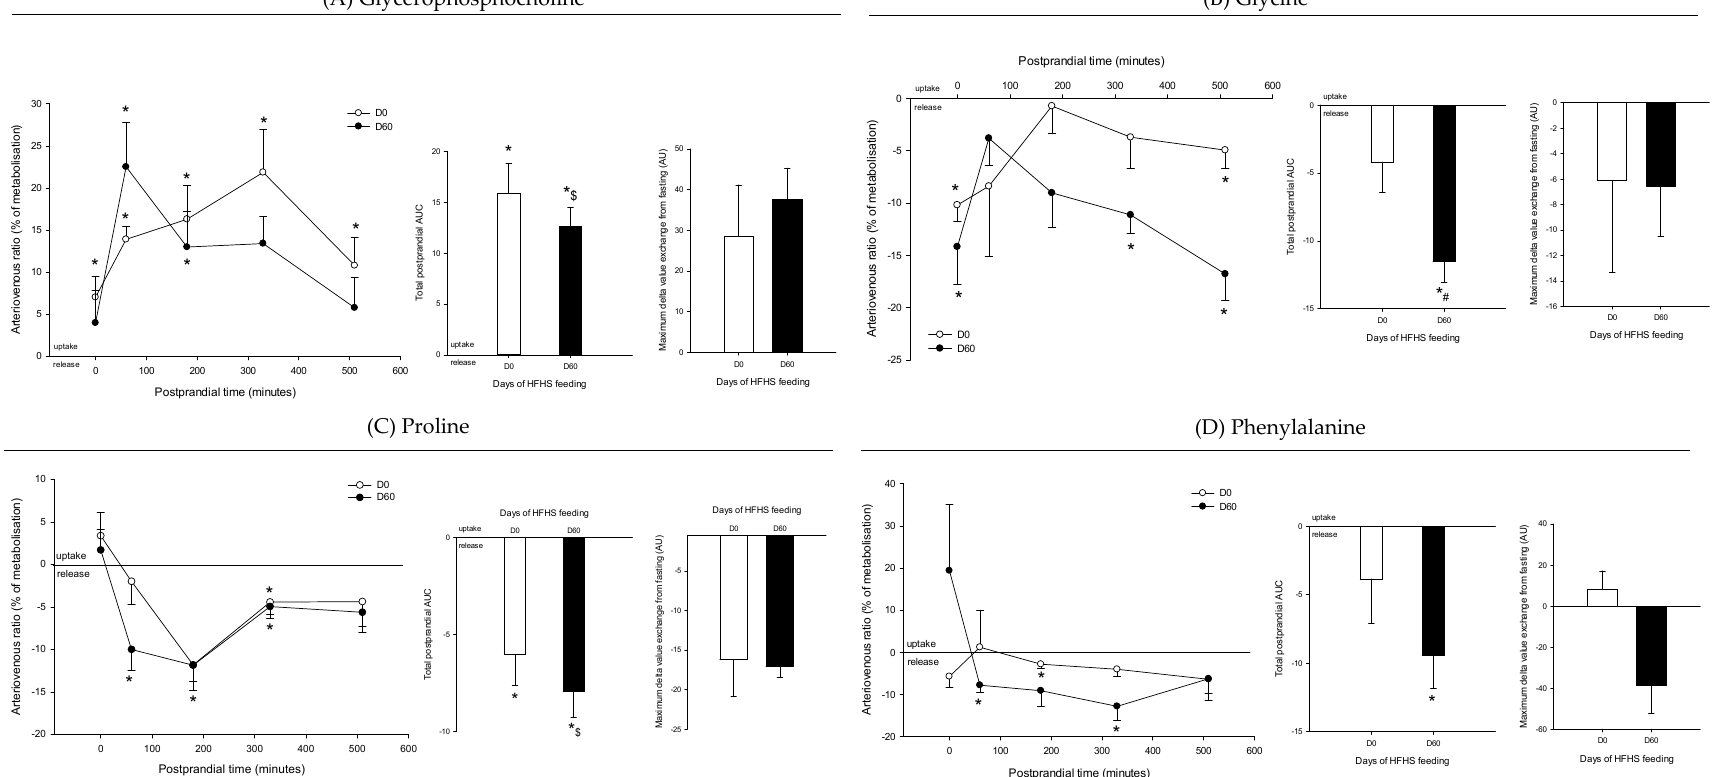
Figure 9. Arteriovenous fold change (A/V) of ( A ) glycerophosphocholine, ( B ) glycine, ( C ) proline, and ( D ) phenylalanine across the intestine on five Yucatan mini-pigs submitted to a HFHS diet during two months. Data is presented in % of induction (mean + sem) and the exchange was analyzed using a repeated-measures t-student test. *, significantly different from 0 (equilibrium), p < 0.05. For the A/V ratios and total postprandial AUC, positive values = taken up by the organ; negative values = released by the organ. #, significantly different from D0, p < 0.05; $, significantly different from the fasting condition, p < 0.05. The maximum delta value exchange from fasting is also presented: the positive and negative values represent an increase or decrease exchange following the meal, respectively.